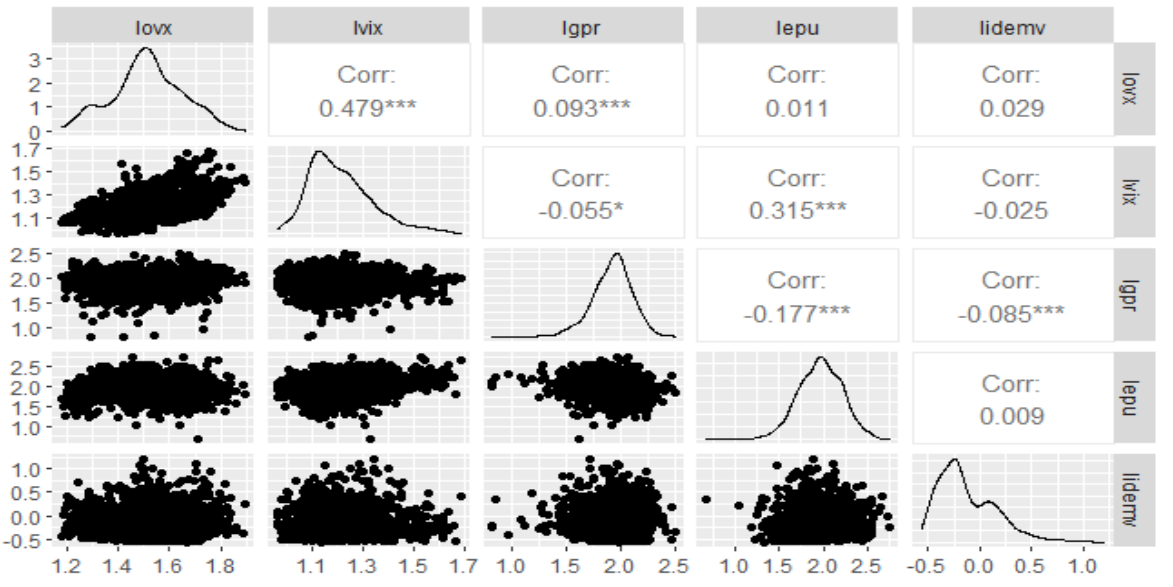
Figure 1. Correlation analysis before COVID-19. Notes: (*) Significant at the 10%; and (***) Significant at the 1%.